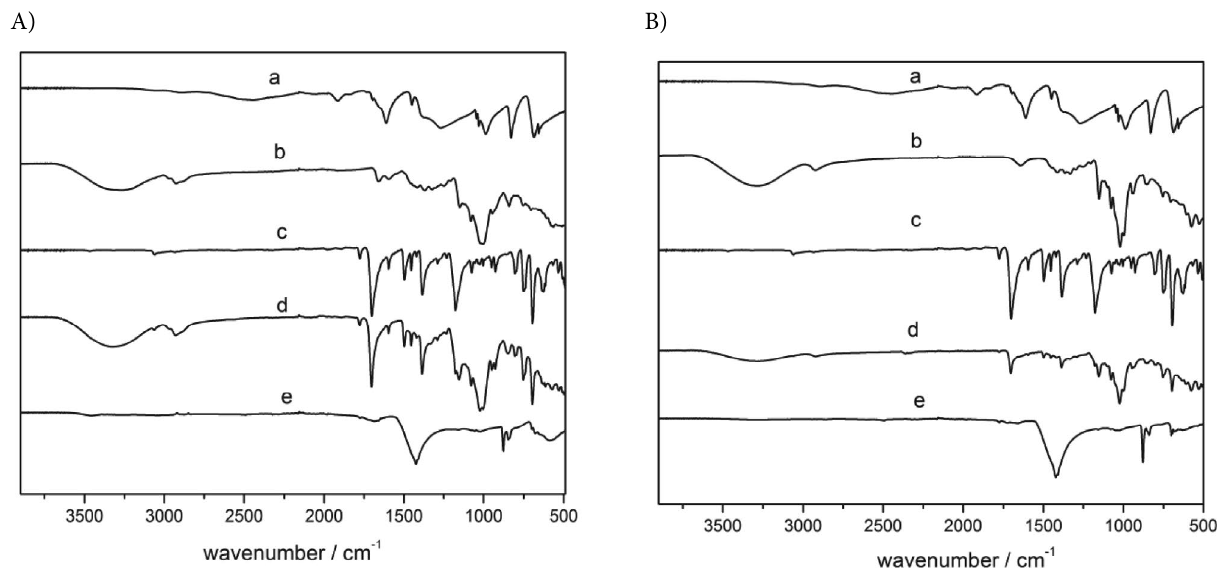
Figure 2 . ATR spectra of the corresponding compounds in the formation of inclusion complex of 1 with HPβCD (A) and βCD (B): (a) NaHCO 3 ; (b) corresponding CD; (c) compound 1 ; (d) physical mixture of the compound 1 and corresponding CD and (e) the inclusion complex of 1 with corre- sponding